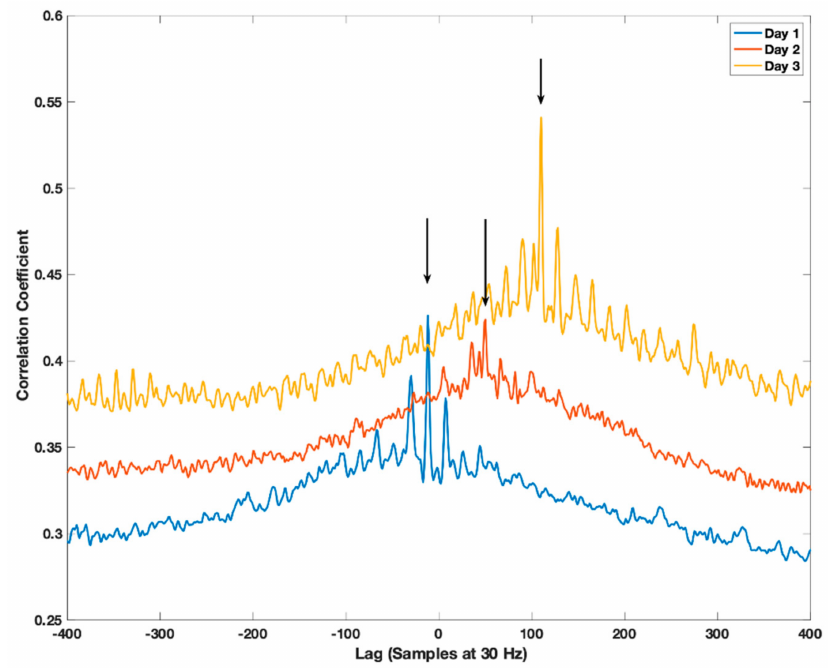
Figure 2. Subject three correlogram for hip and wrist pre-processed acceleration for days 1, 3 and 5. The data block for day 1 and 3 is from 02.00–03.00 PM, whereas for day 2 it is from 03.00–04.00 PM. The arrows identify the peak correlation coefficient which gives the lag and thus time shift between the two 1-h data blocks. The hip-worn monitor is the reference and thus the lag is the number of samples that is required to offset the acceleration of the wrist to align it with the hip